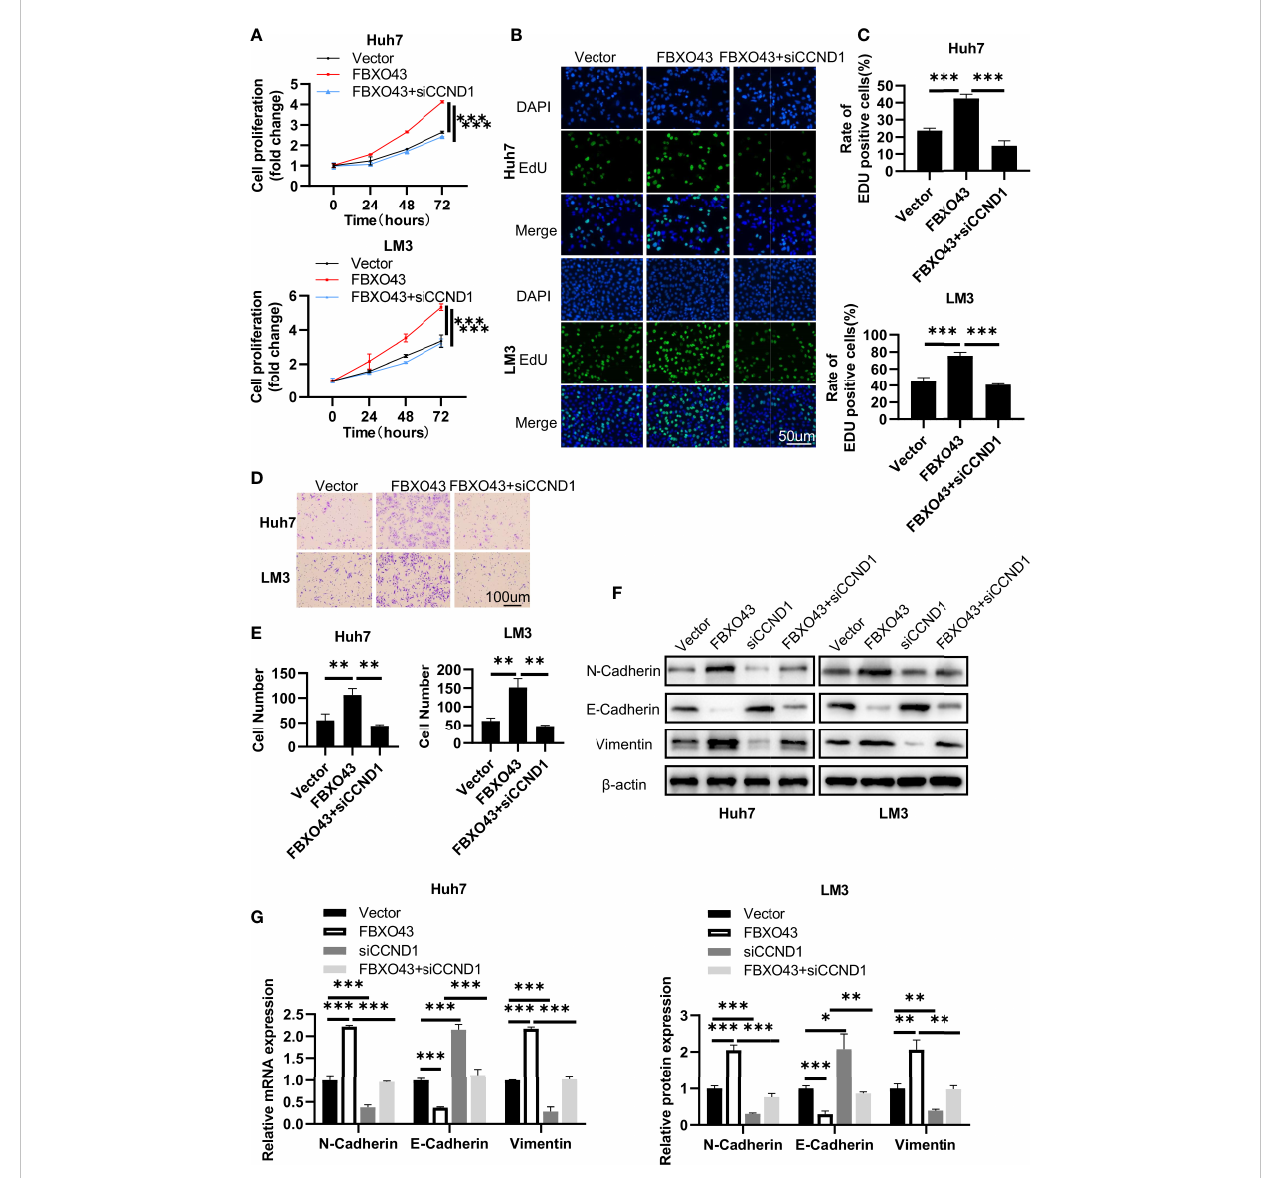
FIGURE 5 Knockdown of CCND1 blocks FBXO43-mediated cell proliferation and migration in HCC cells. (A – C) The cell proliferation levels were analyzed in Huh7 and LM3 cells transfected with Vector, Flag-FBXO43 or Flag-FBXO43+siCCND1 by MTT assay (A) and EdU incorporation assay (B, C) . (D, E) The cell migration levels were analyzed by Transwell assays in Huh7 and LM3 cells treated as in (A) . (F, G) Huh7 and LM3 cells were transfected with Vector, Flag-FBXO43, siCCND1 or Flag-FBXO43+siCCND1 for 48 hrs and then lysed. The protein and mRNA expression of EMT-associated markers was measured by Western blot (F) and qPCR (G) . One-way ANOVA with Tukey ’ s multiple comparisons test was used. *p<0.05, **p<0.01,